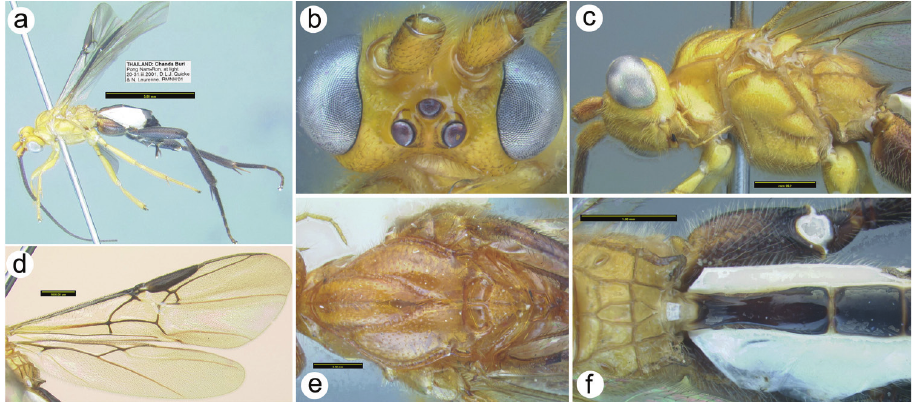
Figure 8. Zelodia longidorsata a lateral habitus b dorsal head c lateral head and mesosoma d wings e dorsal mesosoma f dorsal propodeum and metasomal terga 1 and